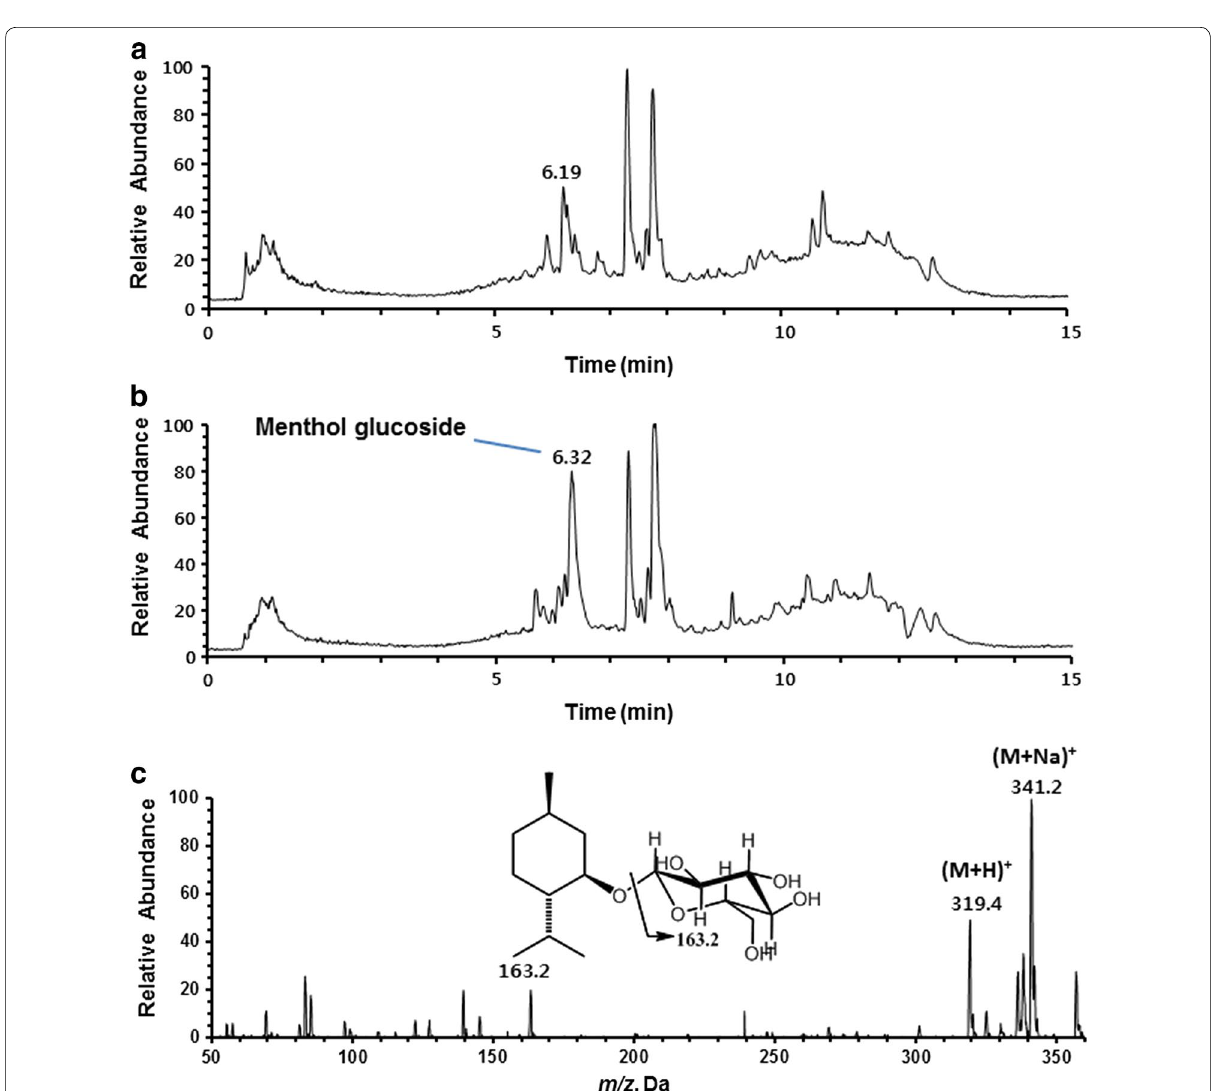
Fig. 2 LC–MS analysis of ( )‑menthol glycosylation reaction by BLC with UDP‑ d ‑glucose. a Total ion chromatogram of the reaction mixture at 0 h − incubation (control reaction); b total ion chromatogram of the reaction mixture at 18 h incubation; c ESI–MS spectrum of the new peak at 6.32